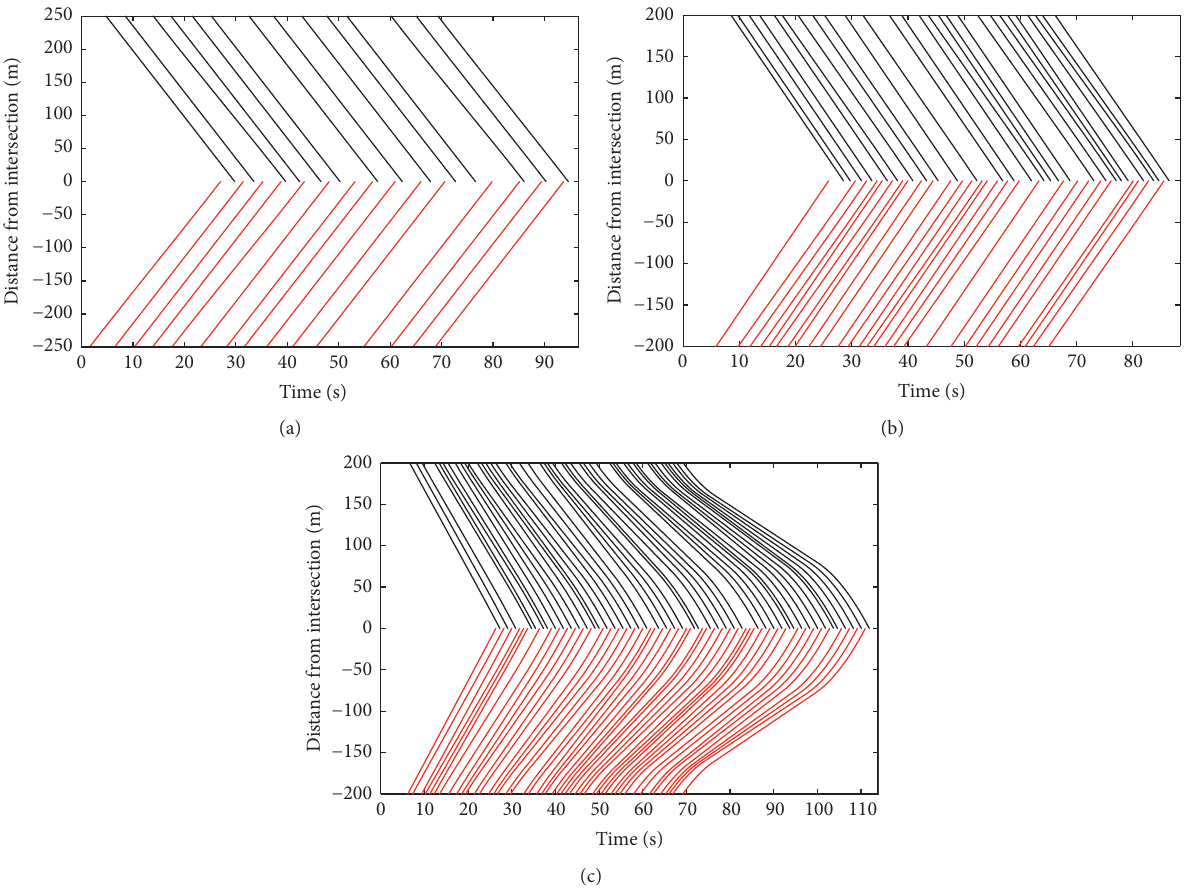
Figure 12: First case study: trajectories of the vehicles inside the CR with respect to time, for different traffic intensities. The top, middle, and bottom graphic plots represent the low, medium, and heavy traffic loads with arrival intensities 10, 30, and 50vpm, respectively. The upper half of the plot corresponds to vehicles of Road 1, while the lower half to vehicles of Road 2.